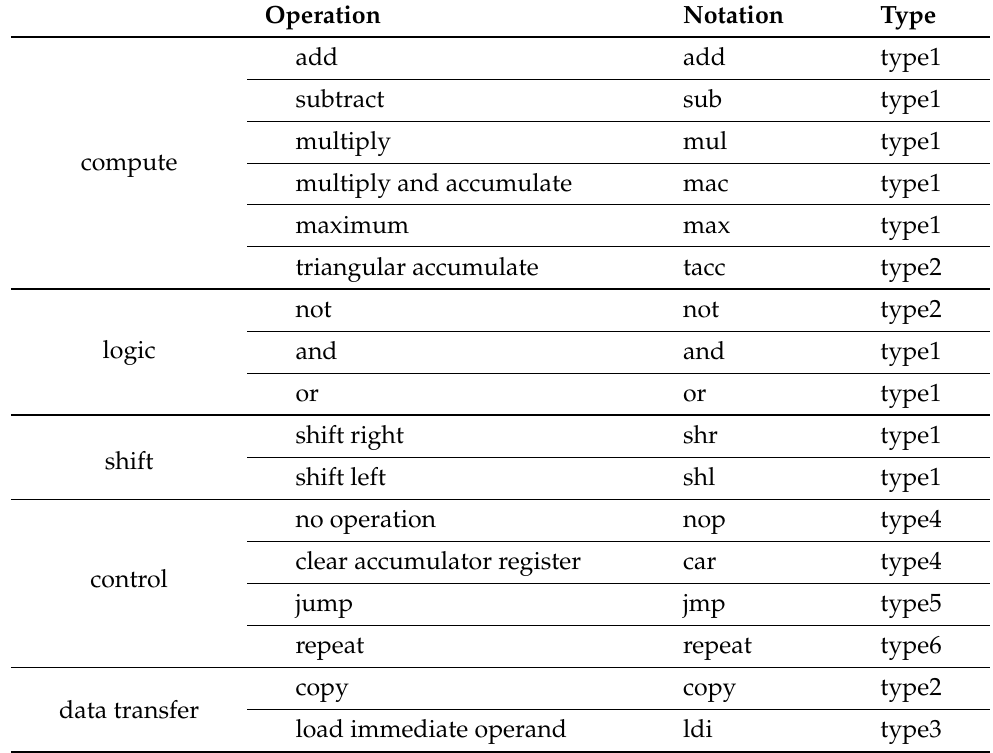
Table 6: register, scratchpad memory(SPM) with register-indirect addressing, immediate, and accumulate register. In addition, we add two customized segments for operands: length and pattern. The length indicates the length of the operand to be executed. The pattern indicates the length of the operand extracted from the SPM. When the pattern is less than the length, the extracted data would be tilted length / pattern times, by which the reused operand is implemented. This is useful for convolution in achieving input tensor reuse. Furthermore, the length segment could also control the executed SIMD lanes, through which our ISA could not only implement the vector operation with variable length, but also the scalar operation. The scalar operation is convenient for control operations and register configuration. Table 3. Overview of the instructions.